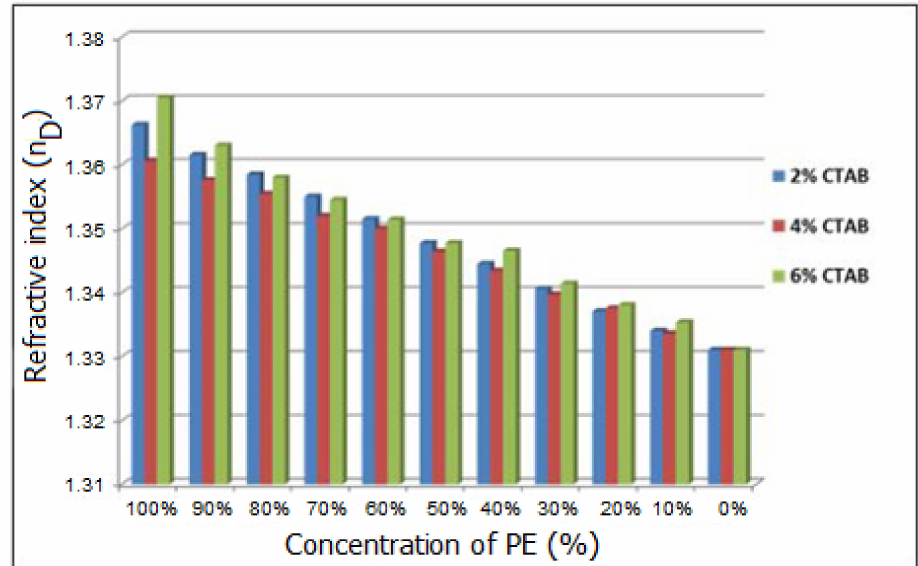
Figure 2. Refractive index for diluted pre-emulsions prepared with different proportions of CTAB.